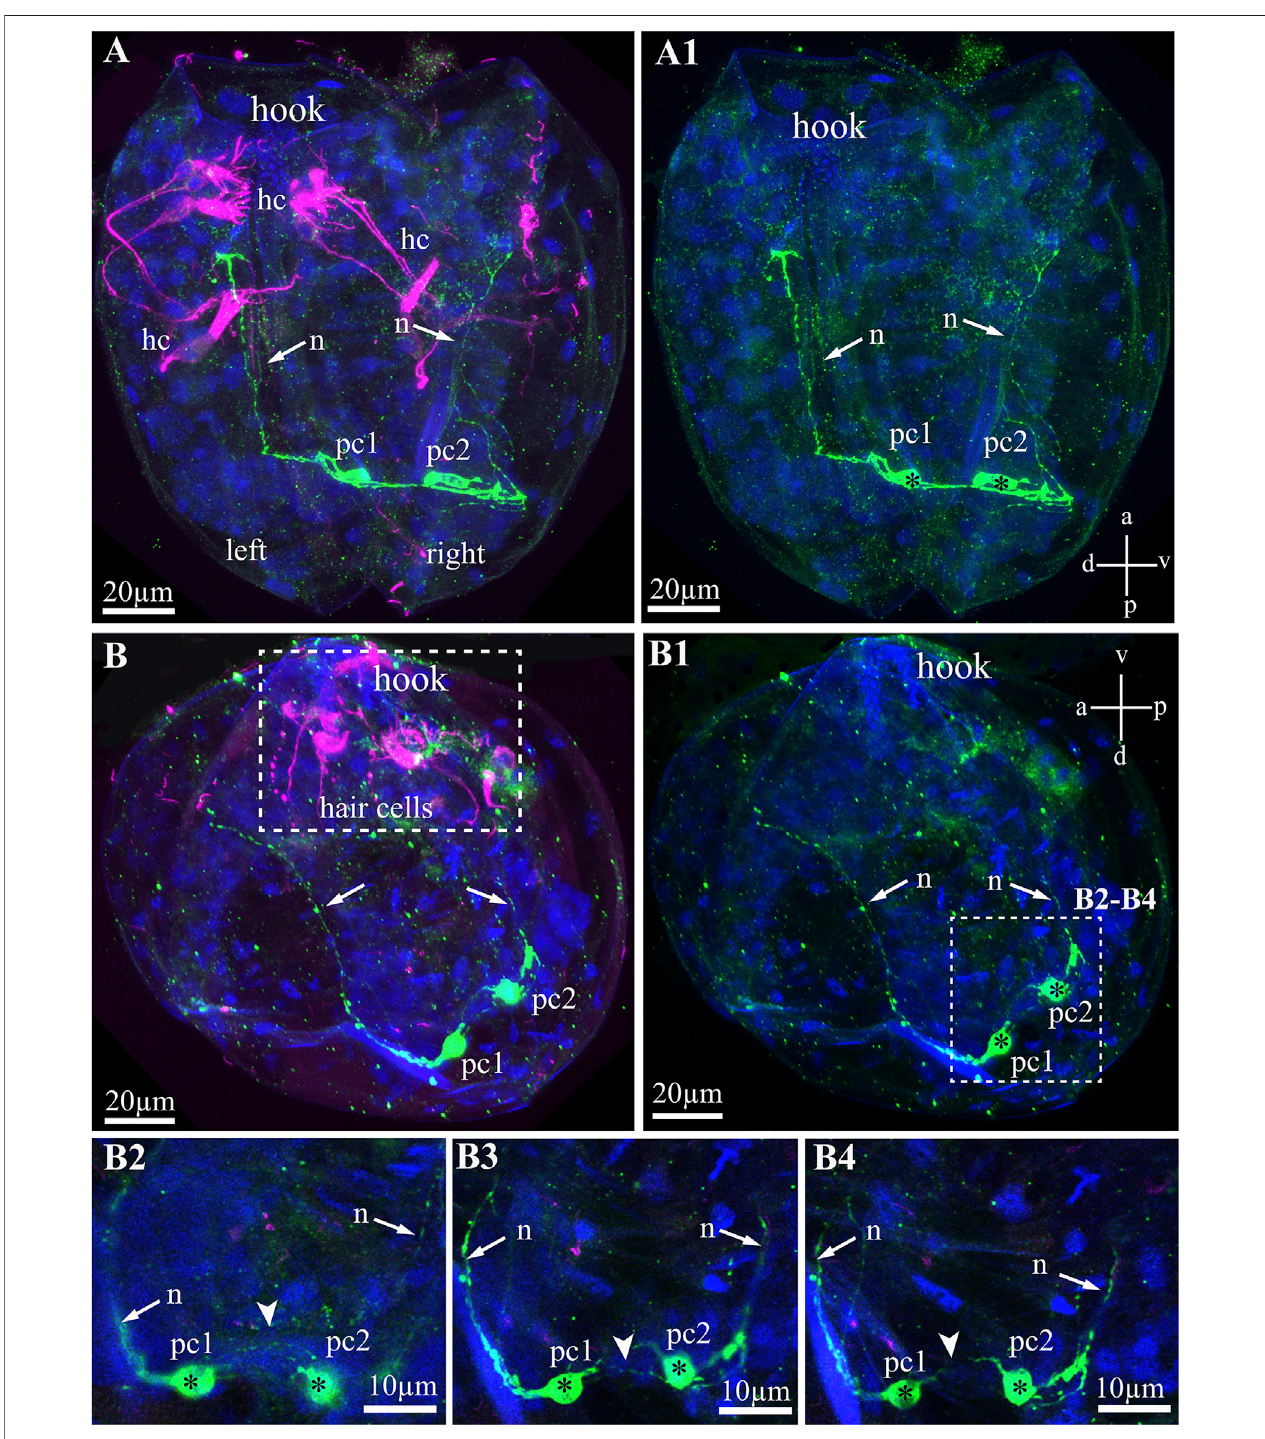
FIGURE 6 | Serotonin-like immunoreactivity (5-HT-lir) in the Nodularia douglasiae glochidia. (A,A1) posterior view; (B,B1) lateral view. Green — 5-HT-lir (A – B1, B2 – B4) ; magenta — hair cells, acetylated tubulin immunoreactivity (A,B,B2 – B4) . (A,A1,B,B1) two 5-HT-lir cells on the posterior part of larva; (B2,B4) insets : high magni fi cation of the two 5-HT-lir cells and their neurites running to the anterior part of larva. (A1) vertical a-p labelled line refers to anterior-posterior body axes and horizontal line d-v labelled line refers to dorso-ventral body axes. (B1) vertical v-d labelled line refers to ventro-dorsal body axes and horizontal line a-p labelled line refers to anterior-posterior body axes of larva. Abbreviations: hc, hair cells; n, neurites, pc, posterior cells. Scale bars, (A – B1) , 20 μ m; (B2 – B4) , 10 μ m.